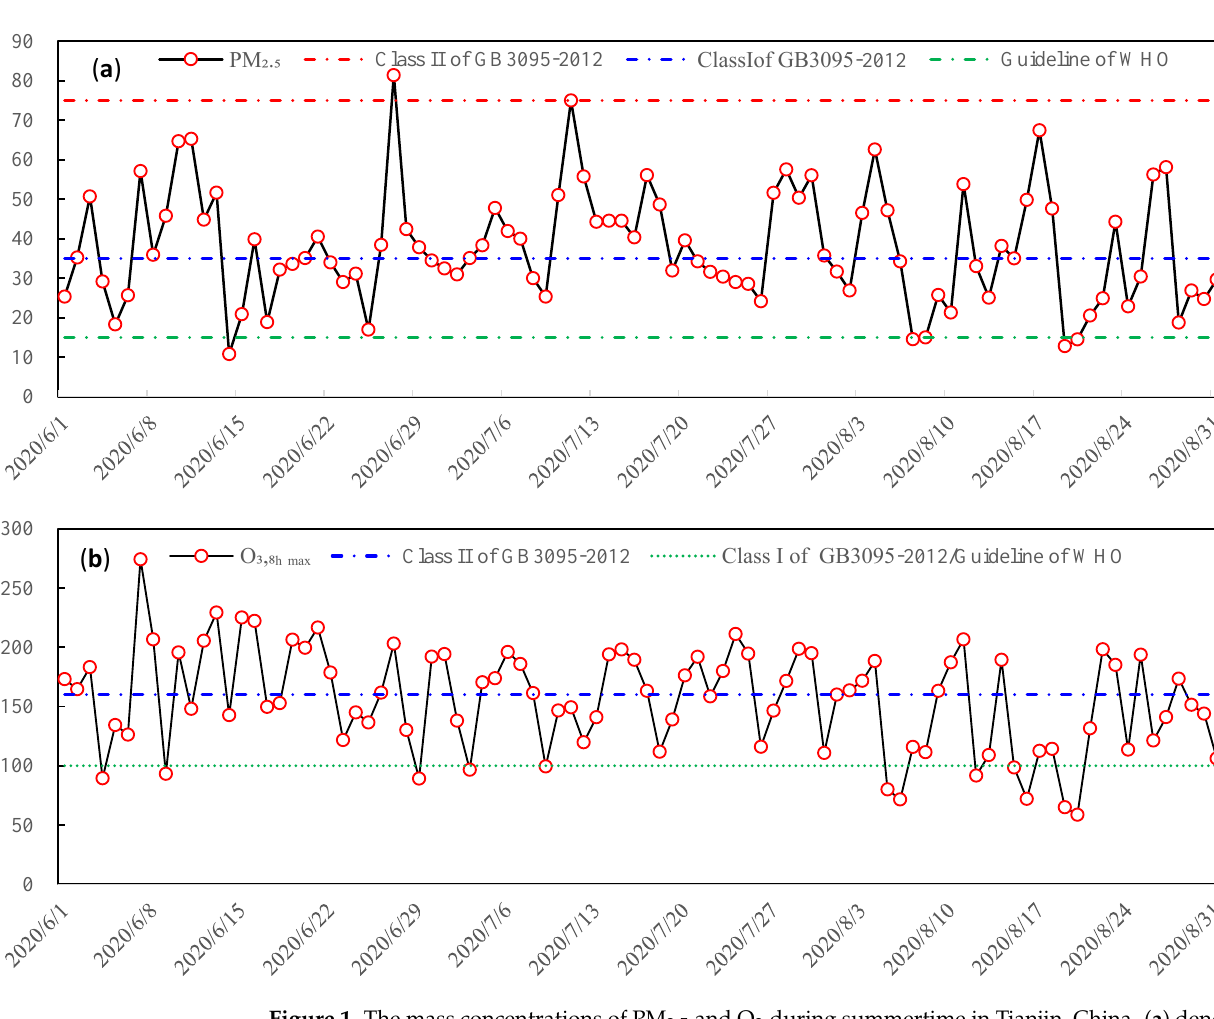
Figure 1. The mass concentrations of PM 2.5 and O 3 during summertime in Tianjin, China. ( a ) denotes PM 2.5 mass concentration. ( b ) denotes O 3 mass concentration.